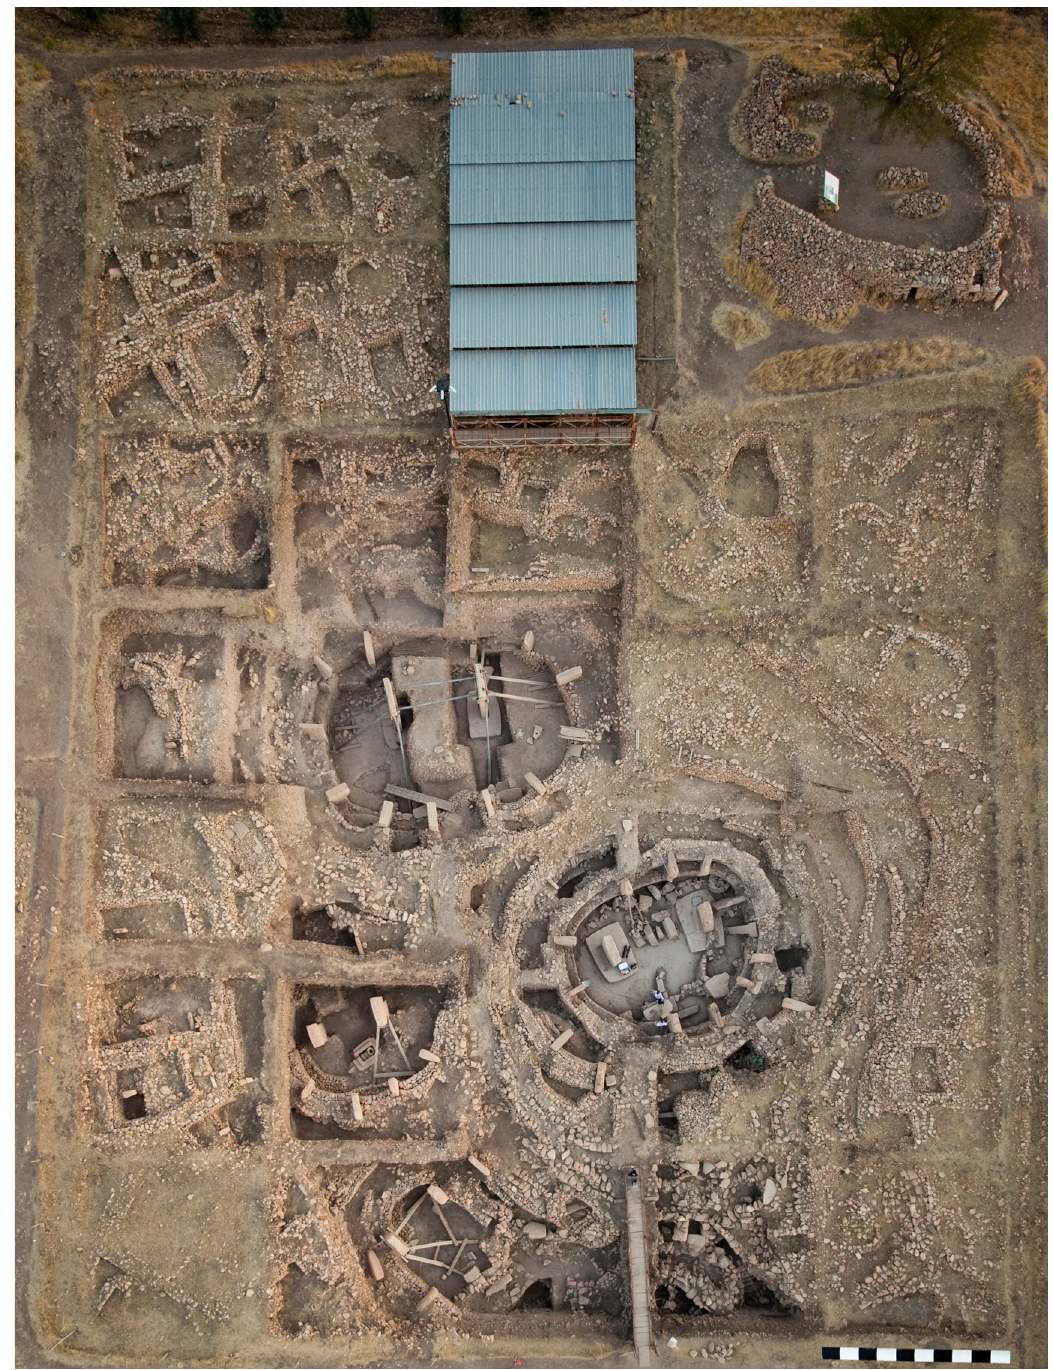
Fig 1. The archaeological site of Go¨bekli Tepe. Main excavation area with four monumental circular buildings and adjacent rectangular buildings (German Archaeological Institute, photo E. Ku¨cu¨k).